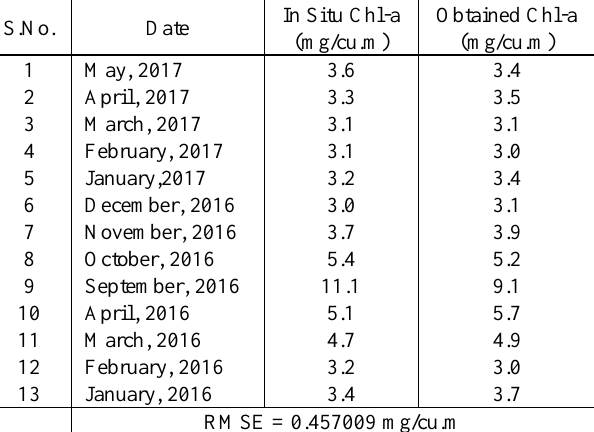
Table 3. Monthly Chl-a concentration at 199497.066 N and 3126164 E along with the obtained value and RMSE for